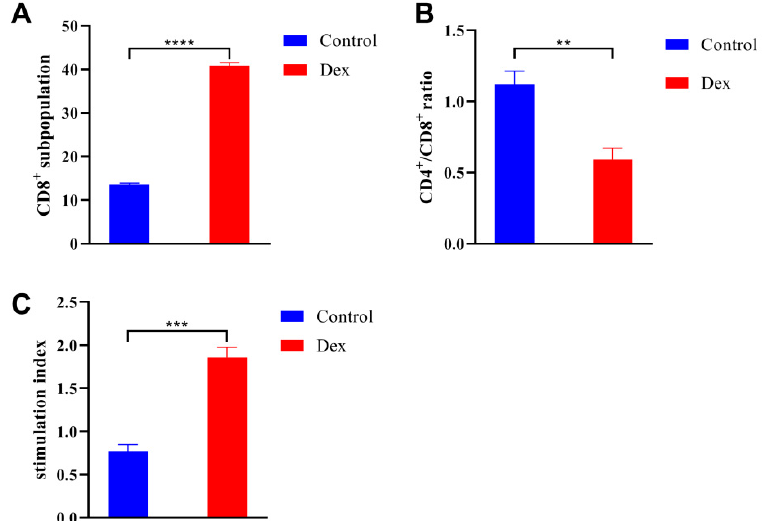
Figure 1. Dexamethasone sodium phosphate treatment lowered the immunity of ICR/CD-1 male mice. ( A ) Dexamethasone sodium phosphate treatment increased the percentage of CD8 + cells in the whole white blood cells. ( B ) The CD4 + /CD8 + ratio from the Dex group was significantly lower than that in the control group. ( C ) The dexamethasone sodium phosphate treatment suppressed the viability of splenic T lymphocyte cells. All data are presented as means ± standard deviation. Two-way ANOVA was used for comparison between the two groups, and all statistical analyses were performed with GraphPad Prism 8. **** p <0.0001; *** p <0.001; ** p <0.01.